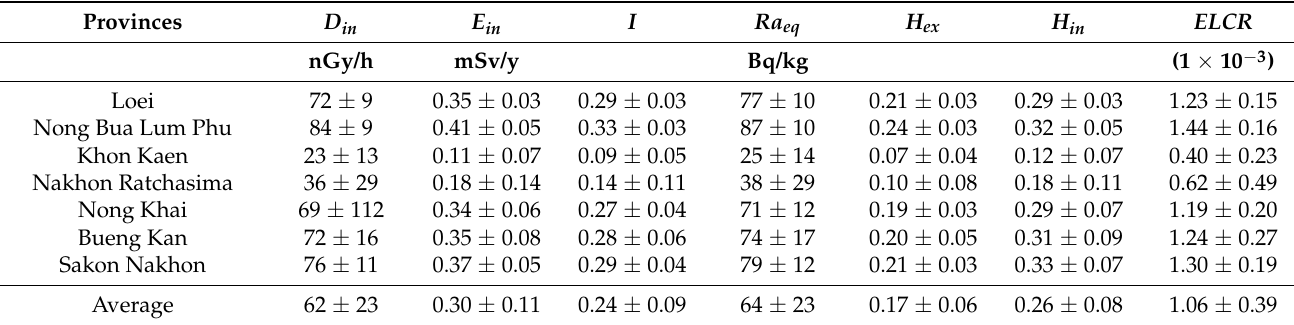
Table 3. The average D in , E in , I , Ra eq , H ex , H in , and ELCR from sand samples collected from Loei, Nong Bua Lam Phu, Khon Kaen, Nakhon Ratchasima, Nong Khai, Bueng Kan, and Sakon Nakhon provinces in Northeastern Thailand. Assume that the sand is used indoor as construction materials (also check Appendix A).